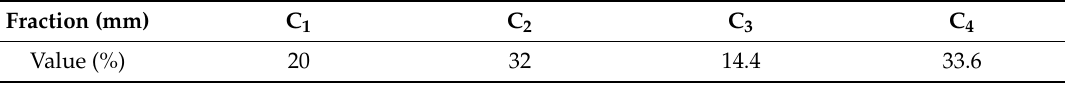
Table 1. Standarized particle size distribution.